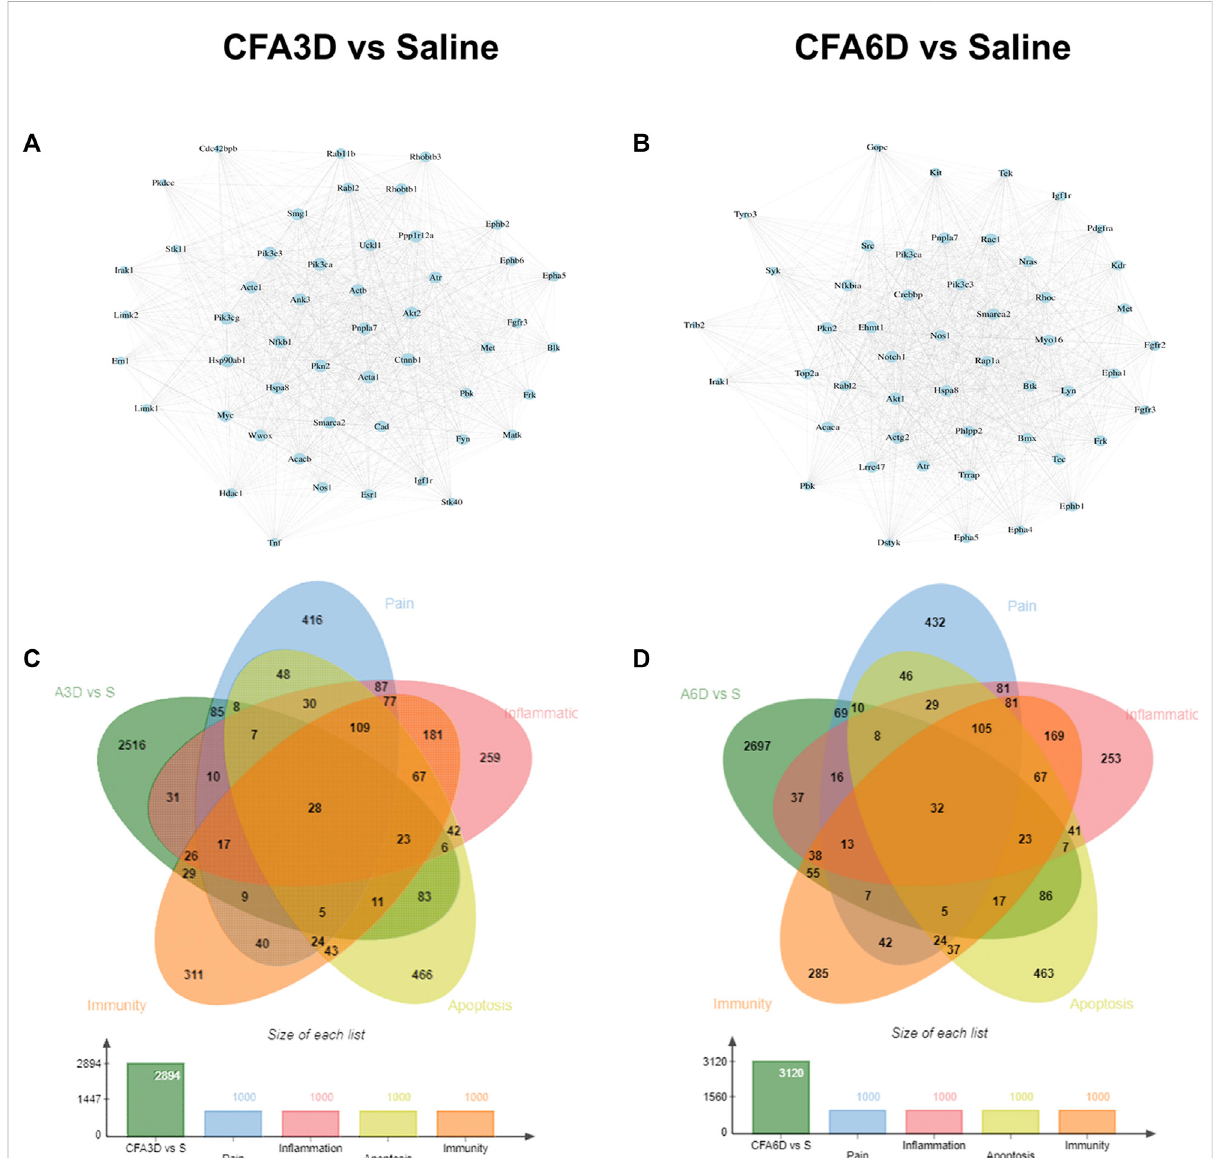
FIGURE 7 PPI network establishments to analyze protein – protein interactions. (A,B) . Top 50 DEGs were picked out based on the connection degree of genesandtheconstructednetwork intheTGonCFA3D (A) andCFA6D (B) .Thesizeofthenoderepresentstheconnection degreethatindicatesthe importanceofthegeneinthenetwork. (C,D) VenndiagramsindicatedthenumberandproportionoftheDEGsmappedtoapoptosis-,in fl ammation- , and immunity-related genes in the TG on CFA3D (C) and CFA6D (D) , respectively.